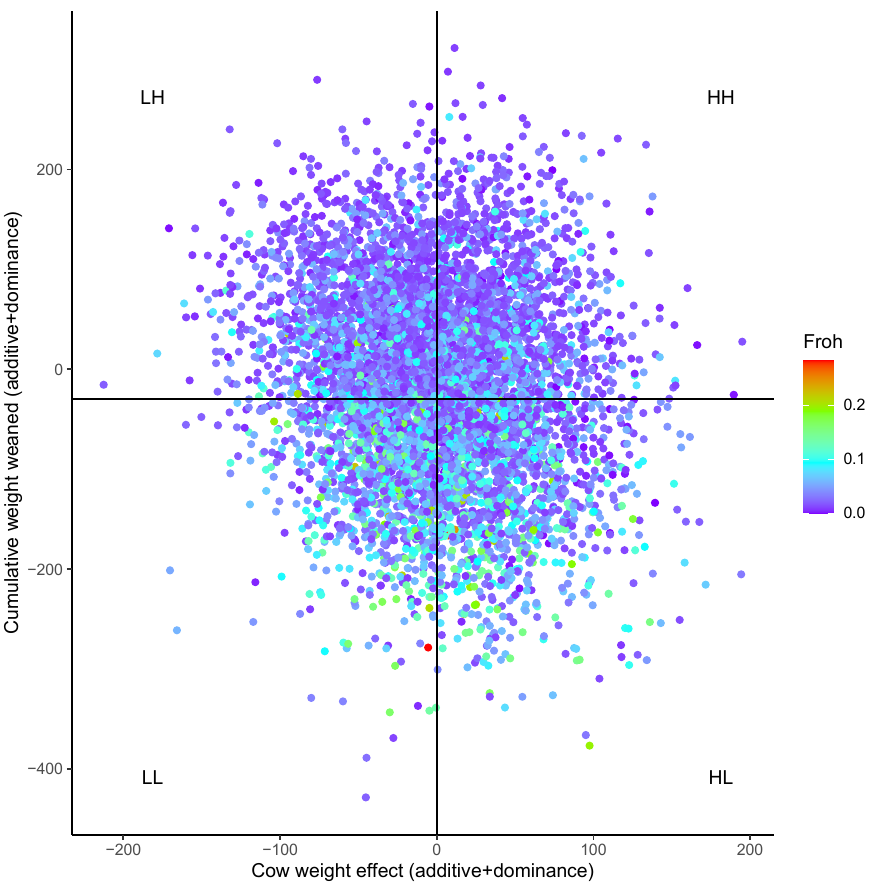
Figure 4. Total genetic effects (additive + dominance) of individual cows projected to eight-year-old cumulative weight weaned (WtW) and cow weight (CW). Each dot represents a single cow. The mean cow weight effect is shown by the vertical line, and mean cumulative weight weaned effect by the horizontal line. Quadrants below and above the means for each trait are labeled: low CW/low WtW (LL), low CW/high WtW (LH), high CW/high WtW (HH), and high CW/low WtW (HL). Colors reflect inbreeding measured by bases under runs of homozygosity (F roh ).